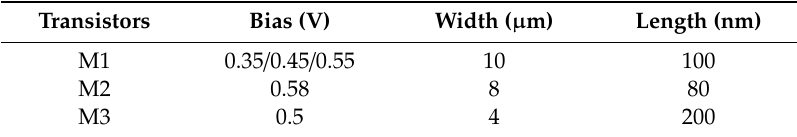
Table 1. Size and bias of the transistors for simulation.